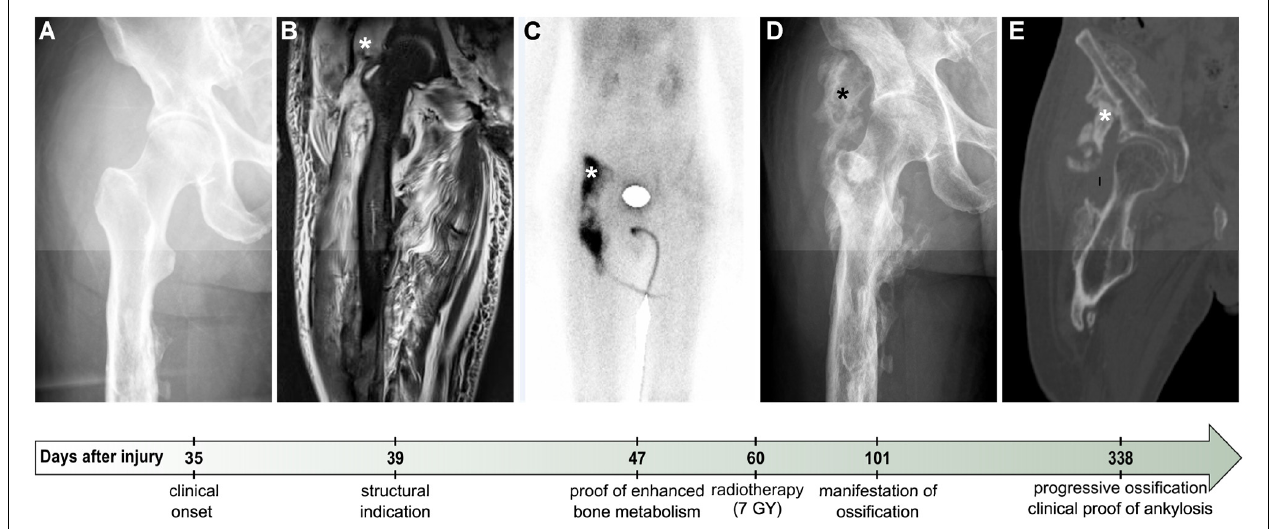
FIGURE 1 | Exemplary clinical course of severe Heterotopic Ossification (ID 13). Plain X-ray (A,D) , MRI (B) , scintigraphy (C) , and CT (E) , in chronological sequence of the clinical course from the onset of symptoms to the decision on surgical resection of HO. “Days after injury” denote the time elapsed since SCI. Depicted stars (*) point to areas of ossification. Four days after first clinical indications of potential HO medical diagnostics were initiated (day 39 after SCI), with plain X-ray still lacking reliable proof of ossification (A) . On the same day, MRI showed suspicious but rather nonspecific diffuse T2 hyperintense muscle signal behavior in the vicinity of the femoral head (B) . Forty-seven days after SCI, enhanced bone metabolism detected by scintigraphy confirmed the previously suspected diagnosis of HO (C) . Despite a performed single-time radiotherapy with 7 Gy on day 60, a clinically relevant ossification was proven by CT more than 2 months after the onset of symptoms (D)